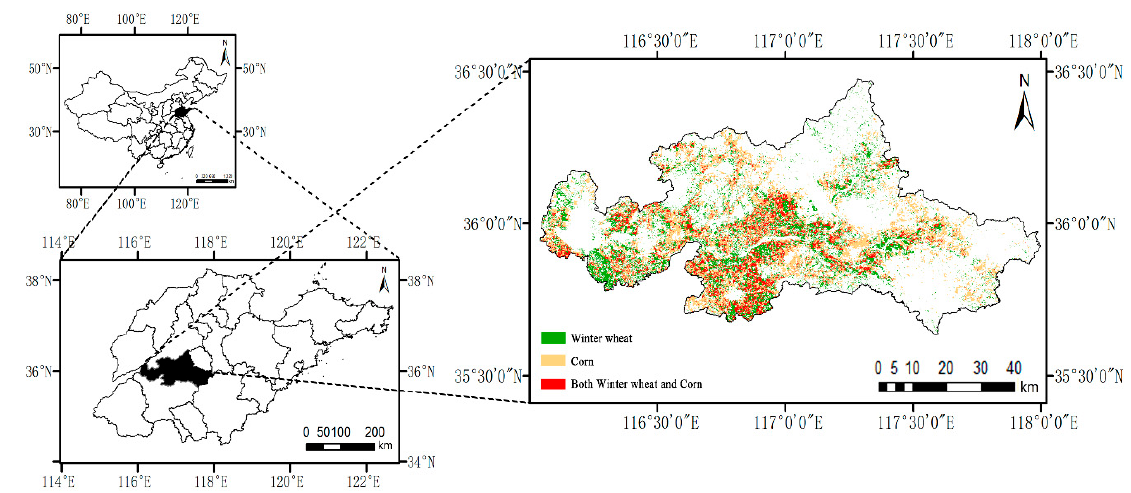
Figure 1. Geographical location and crop distribution for Tai’an City, Shandong Province, China.